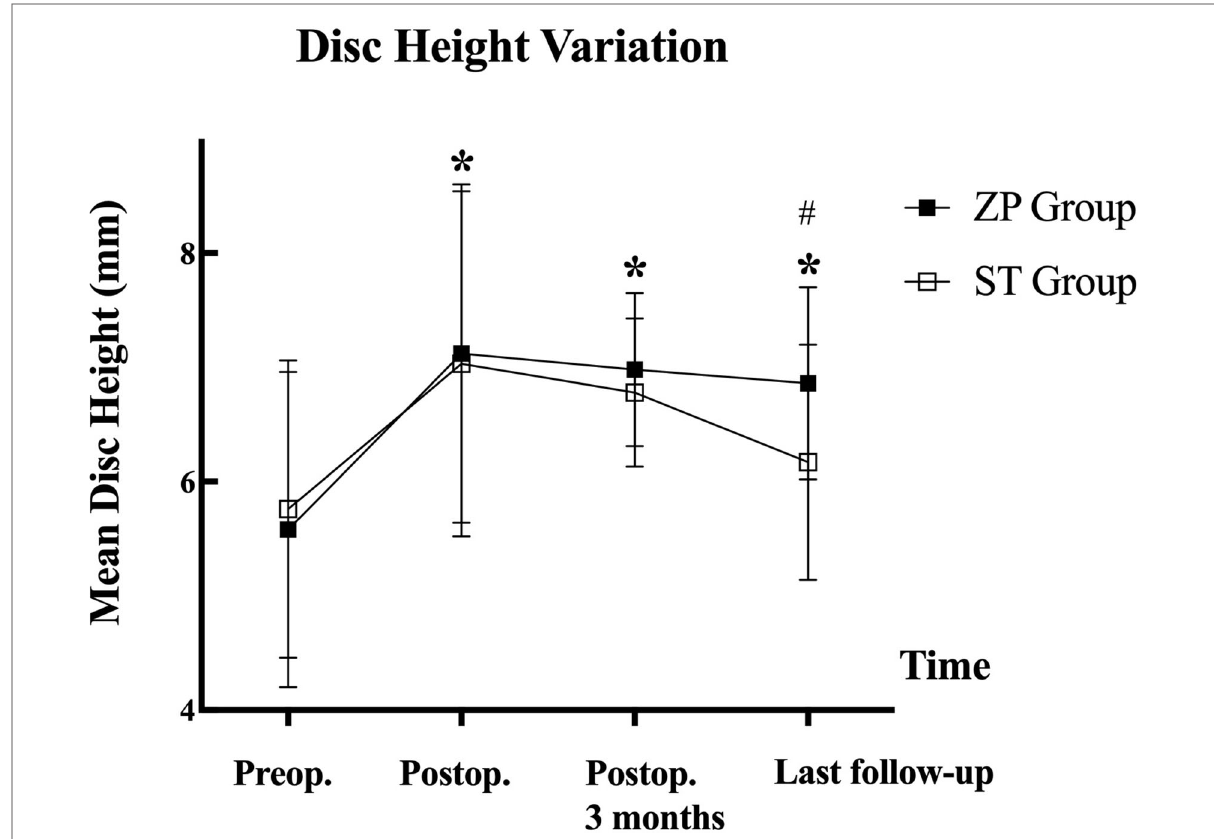
FIGURE 4 Changes of mean cervical disc height during the follow-up for ZP group and ST group. ZP, zero-P cage; ST, stand-alone cage; Preop, preoperative; Postop, postoperative. * P <0.05, compared with preoperative value; # P <0.05 signi fi cant difference between the two groups.